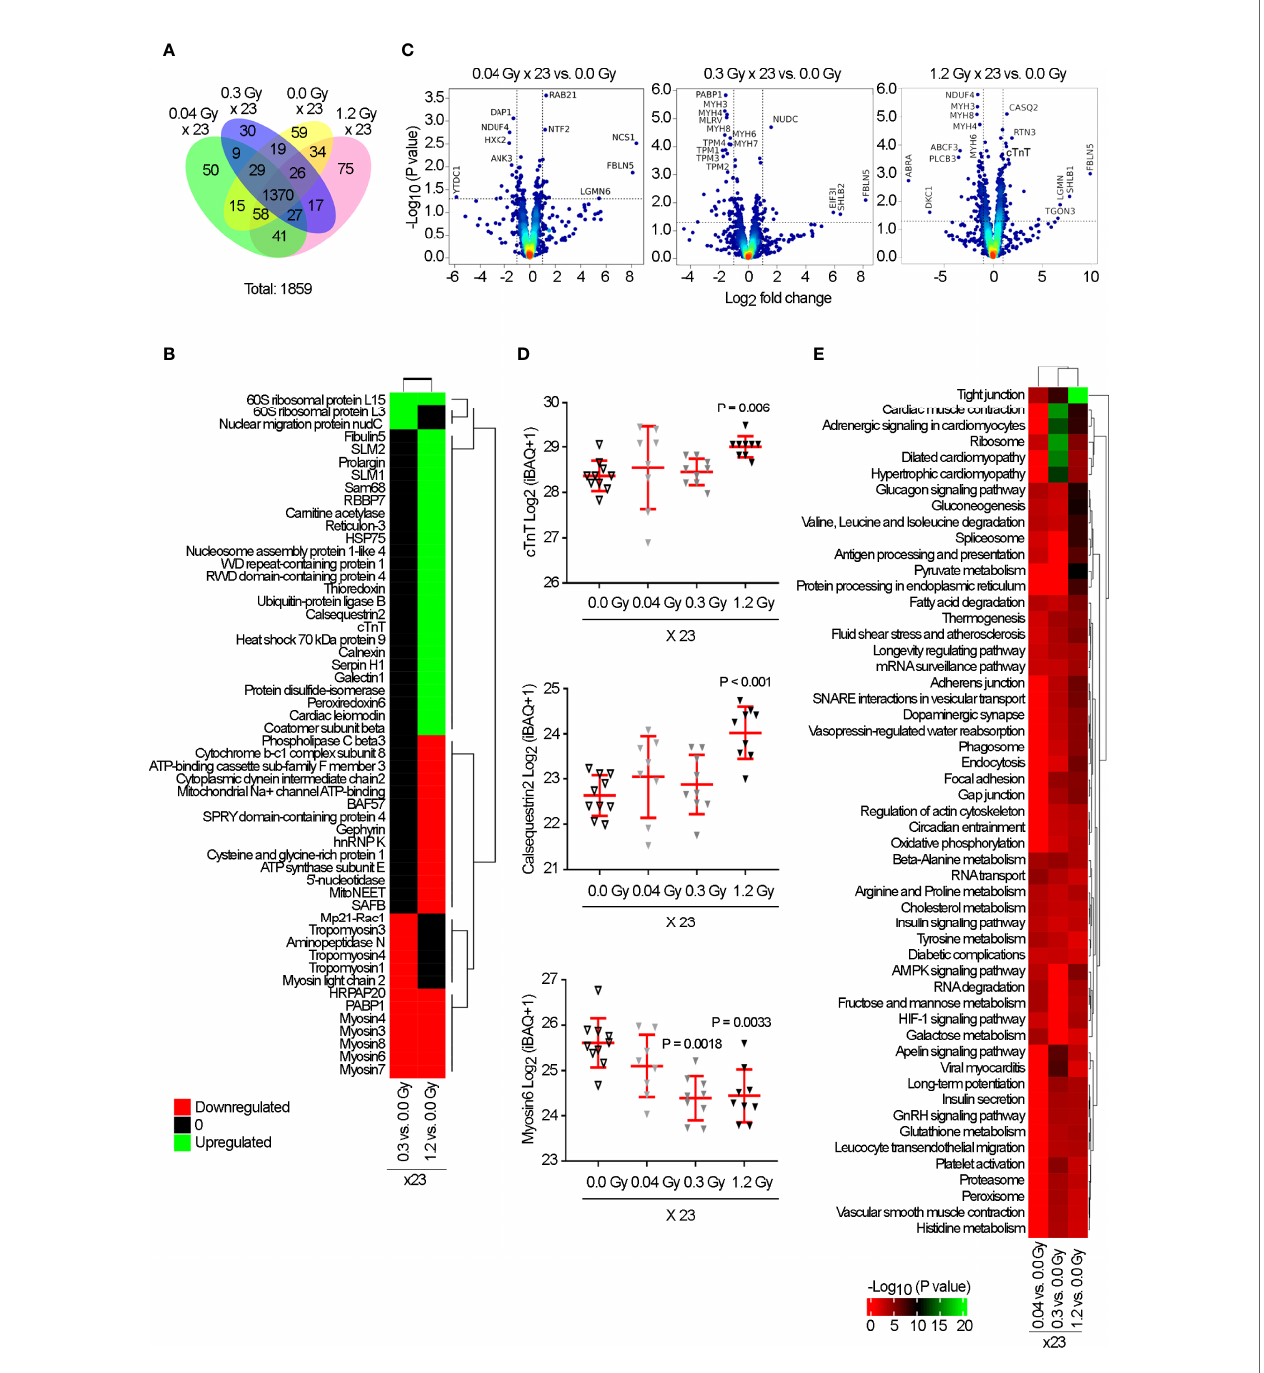
FIGURE 5 | Proteomic analysis reveals a signi fi cant change in the expression of cTnT, Calsequestrin2, and Myosin6, in response to the cumulative doses of 0.92, 6.9, and 27.6 Gy. Rat hearts were sham-irradiated (n = 10) or irradiated with 0.04 (n = 8), 0.3 (n = 9), or 1.2 Gy (n = 9) for 23 daily fractions and analyzed by mass spectrometry at 7 months. (A) Venn diagram indicates the non- and overlapping number of proteins. (B) Heatmap represents the signi fi cantly up (green) and downregulated (red) proteins (adjusted P -value <0.05) from each group vs. sham-irradiated. (C) Volcano plots based on Log 2 fold change against − Log 10 ( P -value) show the signi fi cantly up (upper right corner) and downregulated (upper left corner) proteins in each group vs. 0.0 Gy. (D) Quantitative Log 2 (iBAQ + 1) expression values show the signi fi cant upregulation of cTnT and Calsequestrin2 by 1.2 Gy, and downregulation of Myosin6 by 0.3 and 1.2 Gy. Individual data and mean ± SD (in red) are shown. A Kruskal – Wallis test with Dunn ’ s correction was used; signi fi cant P- values are displayed. (E) Heatmap of KEGG pathway enrichment analysis, for signi fi cantly dysregulated proteins, revealed “ Tight junctions, ” “ Cardiac muscle contraction, ” and “ Adrenergic signaling in cardiomyocytes ” as signi fi cantly enriched exclusively by 0.3 and 1.2 Gy. Color intensity indicates an enrichment